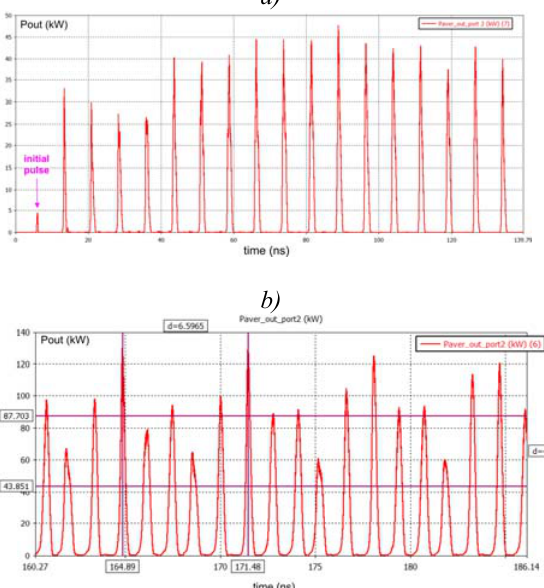
Fig. 3. Results of PIC simulations for generation of a se- quence of ultrashort pulses in a two-section microwave oscillator with passive mode locking. The hard (a) and soft (b) self-excitation modes are